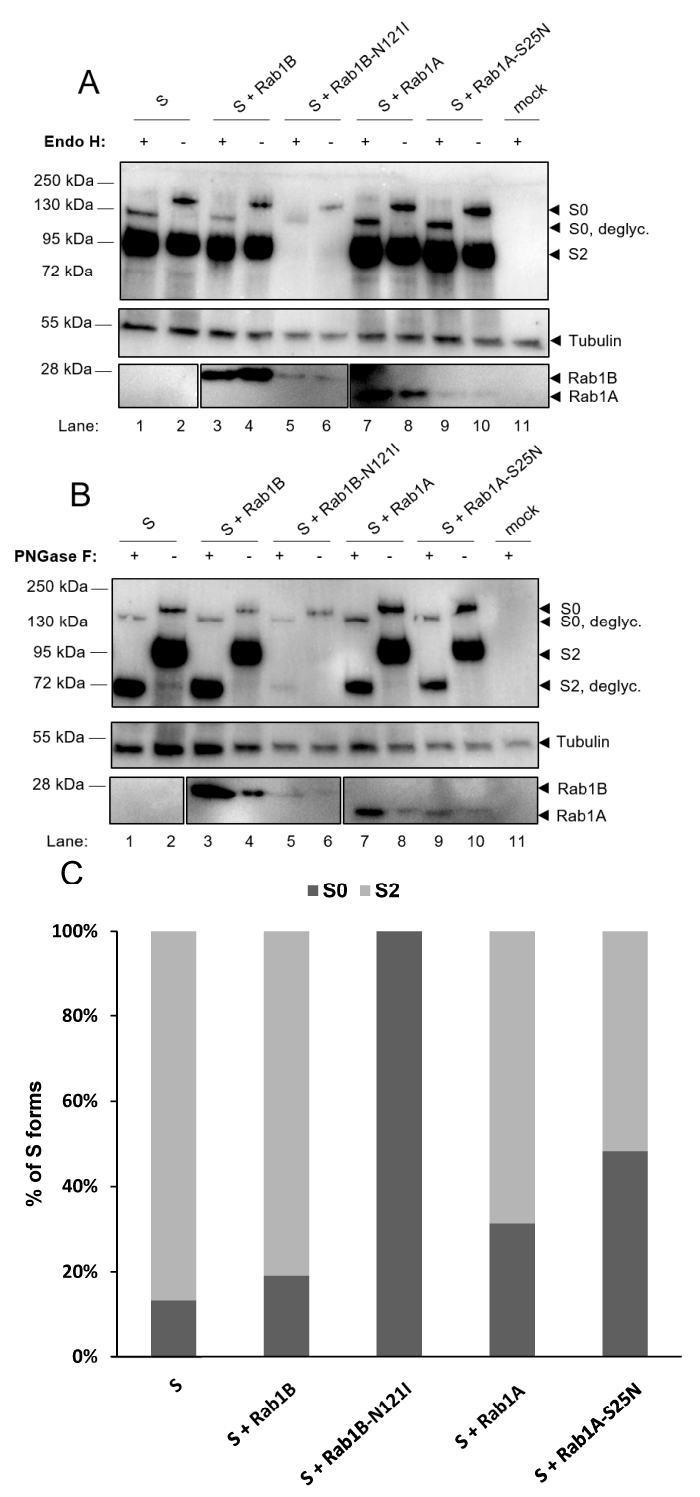
Figure 5. Rab1B-N121I efficiently inhibits maturation of SARS-CoV-2 S. Subconfluent HuH7 cells were transfected with 1 µ g pCAGGS-S and 3 µ g pCMV-Rab1A-myc and pCMV-Rab1B-myc; the corresponding DN mutants or empty vector pCAGGS as a control, respectively. Cells were harvested at 24 hpt and cell lysates were treated with either ( A ) Endo H or ( B ) PNGase F for 1 h. Immunoblots were stained for S, Rab1A/Rab1B (anti-myc) and tubulin. ( C ) Levels of S0, S2 and Tubulin from ( A ) were quantified and the ratio of S0 and S2 was calculated. The values in the graph represent triplicates from three independent